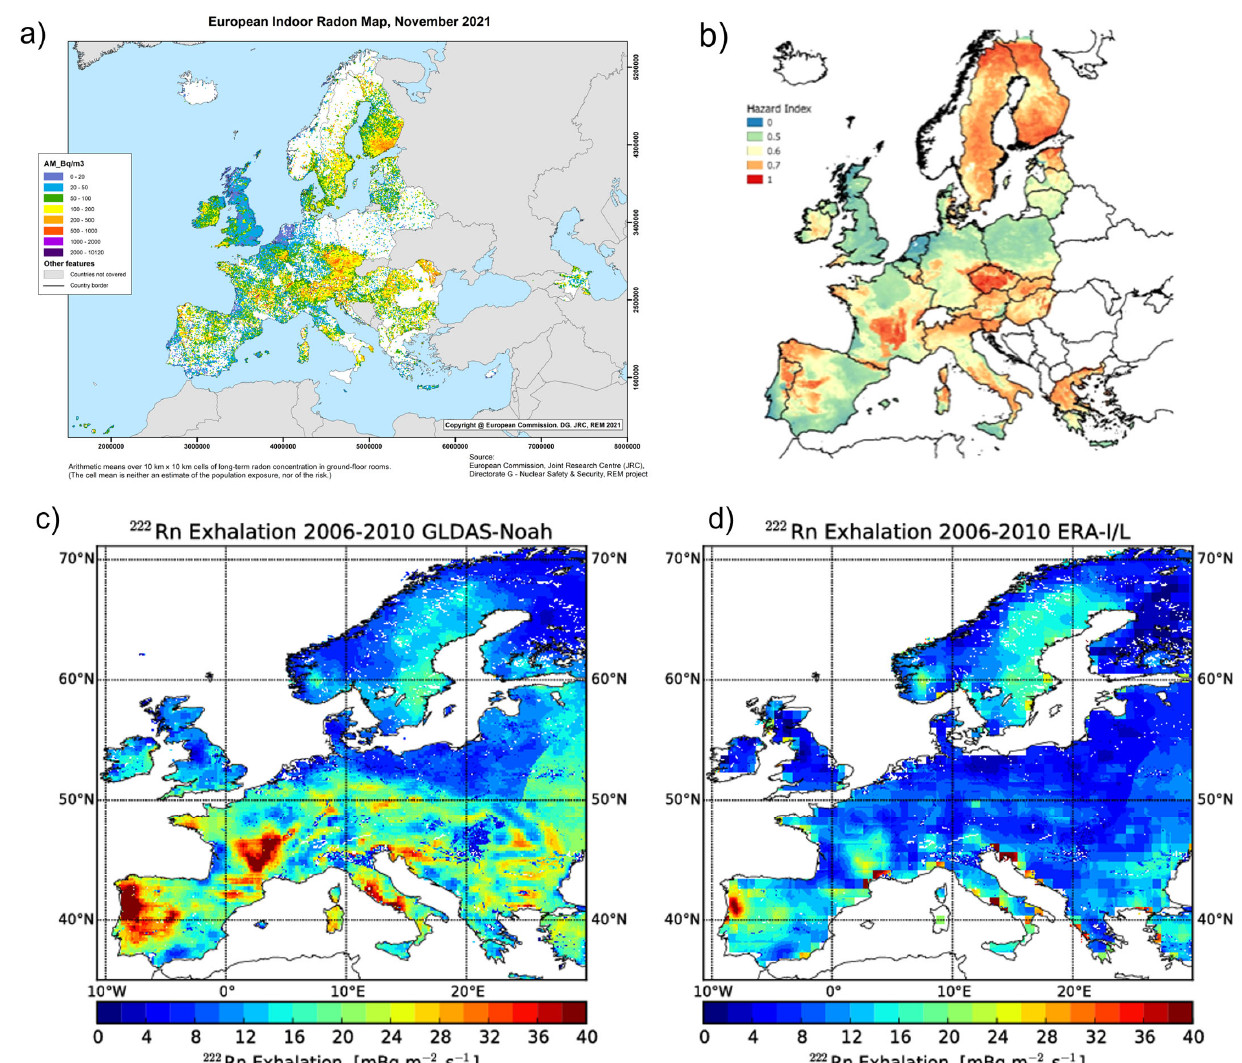
Figure 9. ( a ) Indoor radon map of Europe [263], ( b ) Map of Geogenic Radon Hazard Index [44], ( c ) Rn flux map of Karstens with GLDAS ‐ Noah [65], ( d ) Rn flux map of Karstens with ERA ‐ I/L [65].